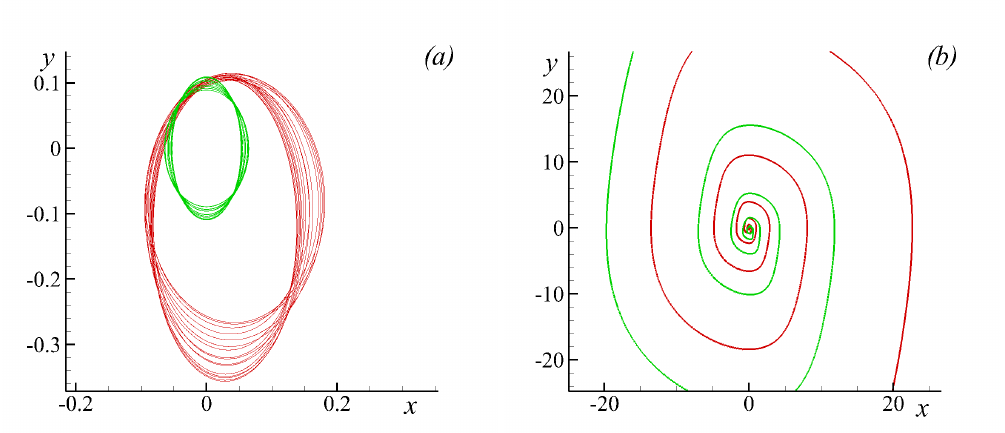
Figure 1. Examples of trajectories of the point-vortex system: ( a ) in the absence of parametric instability (bounded trajectories); and ( b ) provided parametric instability (spiralling unbounded trajectories).